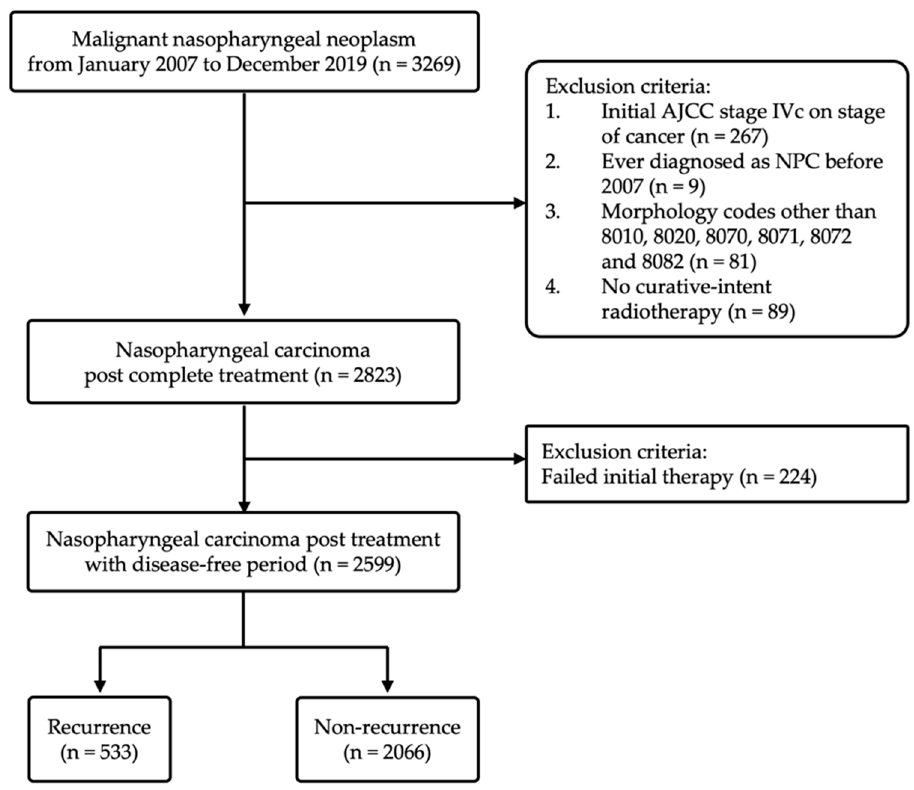
Figure 1. Flow chart of the cohort study design.